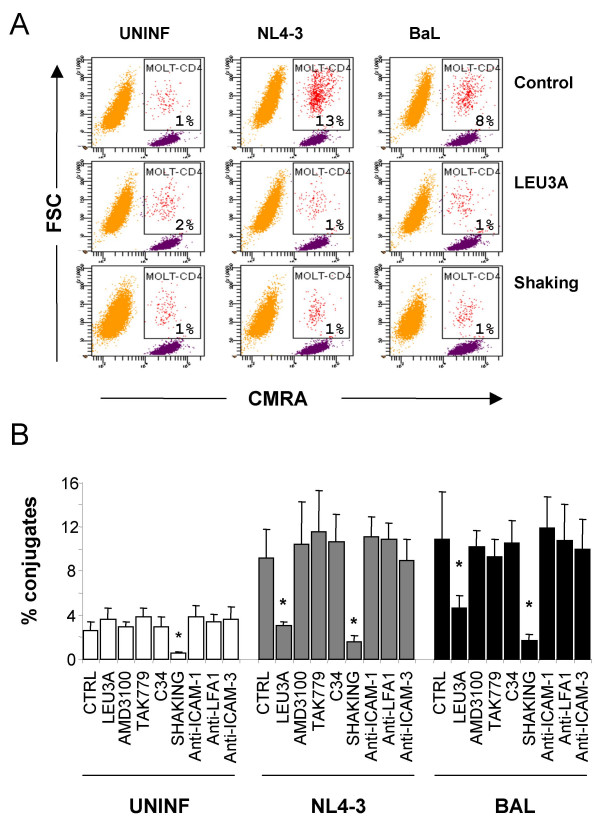
Formation of T cell-T cell conjugates. Panel A shows a representative experiment of quantification of cellular contacts between MOLT cells and purified CMRA-labeled CD4 T cells. MOLT cells appear as an unstained population with high forward scatter values (in orange); while CD4 T cells were identified by fluorescent staining and low forward scatter values (in purple). Events displaying bright fluorescence and forward scatter values consistent with MOLT cells were defined as cellular conjugates (in red, gate MOLT-CD4 in the figure). The percentage of CD4 T cells forming conjugates in the absence or the presence of Leu3a, or under continuous shacking condition is shown in each plot. Panel B shows the quantification of cellular conjugates in the presence of the following inhibitors: mAbs against the adhesion molecules ICAM-1 (RM3A5), ICAM-3 (140.11) and LFA-1 (R7.1), coreceptor antagonists AMD3100 and TAK779 (all at 10 μg/ml), gp41 inhibitor C34 (1 μg/ml) or Leu3a (5 μg/ml). Data are Mean ± SD of 3 independent experiments including cells from 3 different donors. Asterisks indicate a significant inhibition in the formation of conjugates in the presence of Leu3a and under shaking conditions.